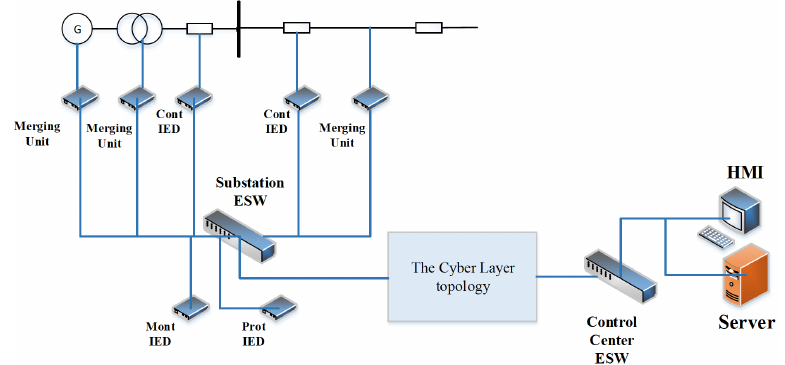
Figure 1. The cyber layer connection within the